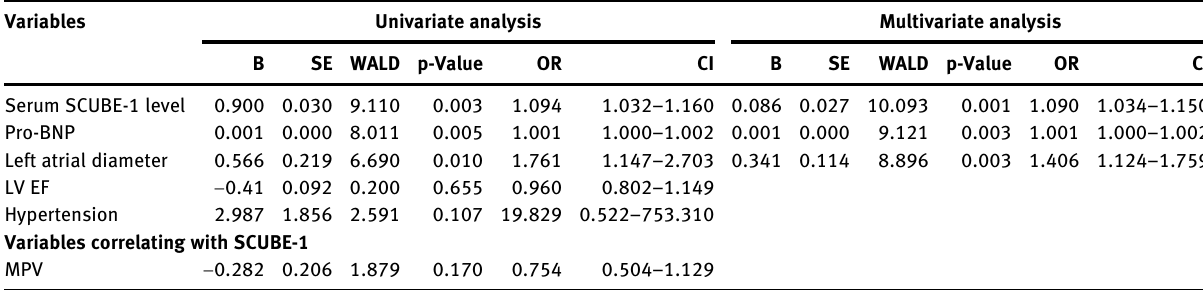
Table  : Univariate and Multivariate